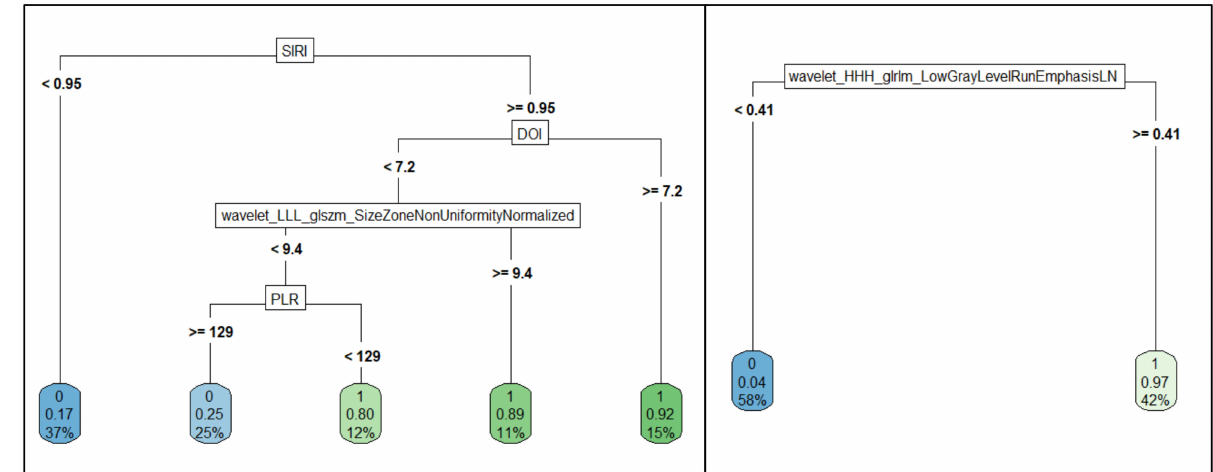
Figure 1. Decision trees obtained with the CART algorithm for the prediction of tumor grading ( left panel) and metastatic lymph nodes ( right panel).